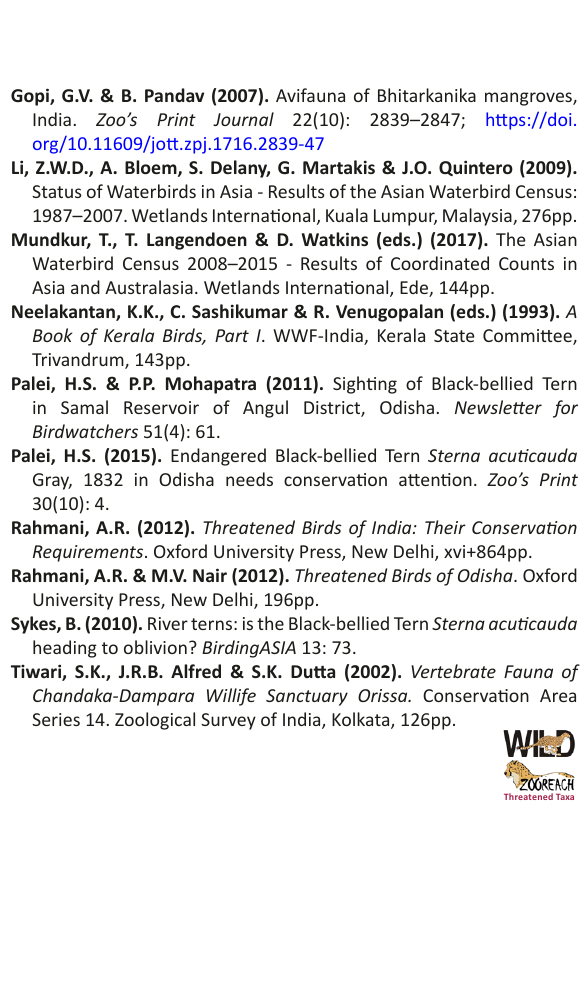
Image 3. A Black-bellied Tern incubating its eggs on an island in the Mahanadi River in Odisha, eastern India. Sand mining is a regular activity near these breeding and nesting sites at Mundali.